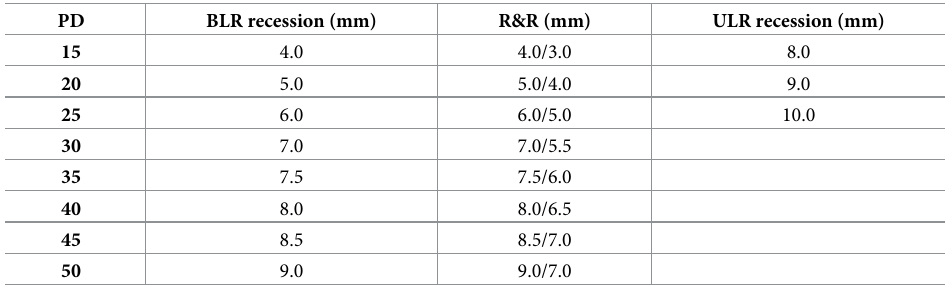
Table 1. Surgical dosages for